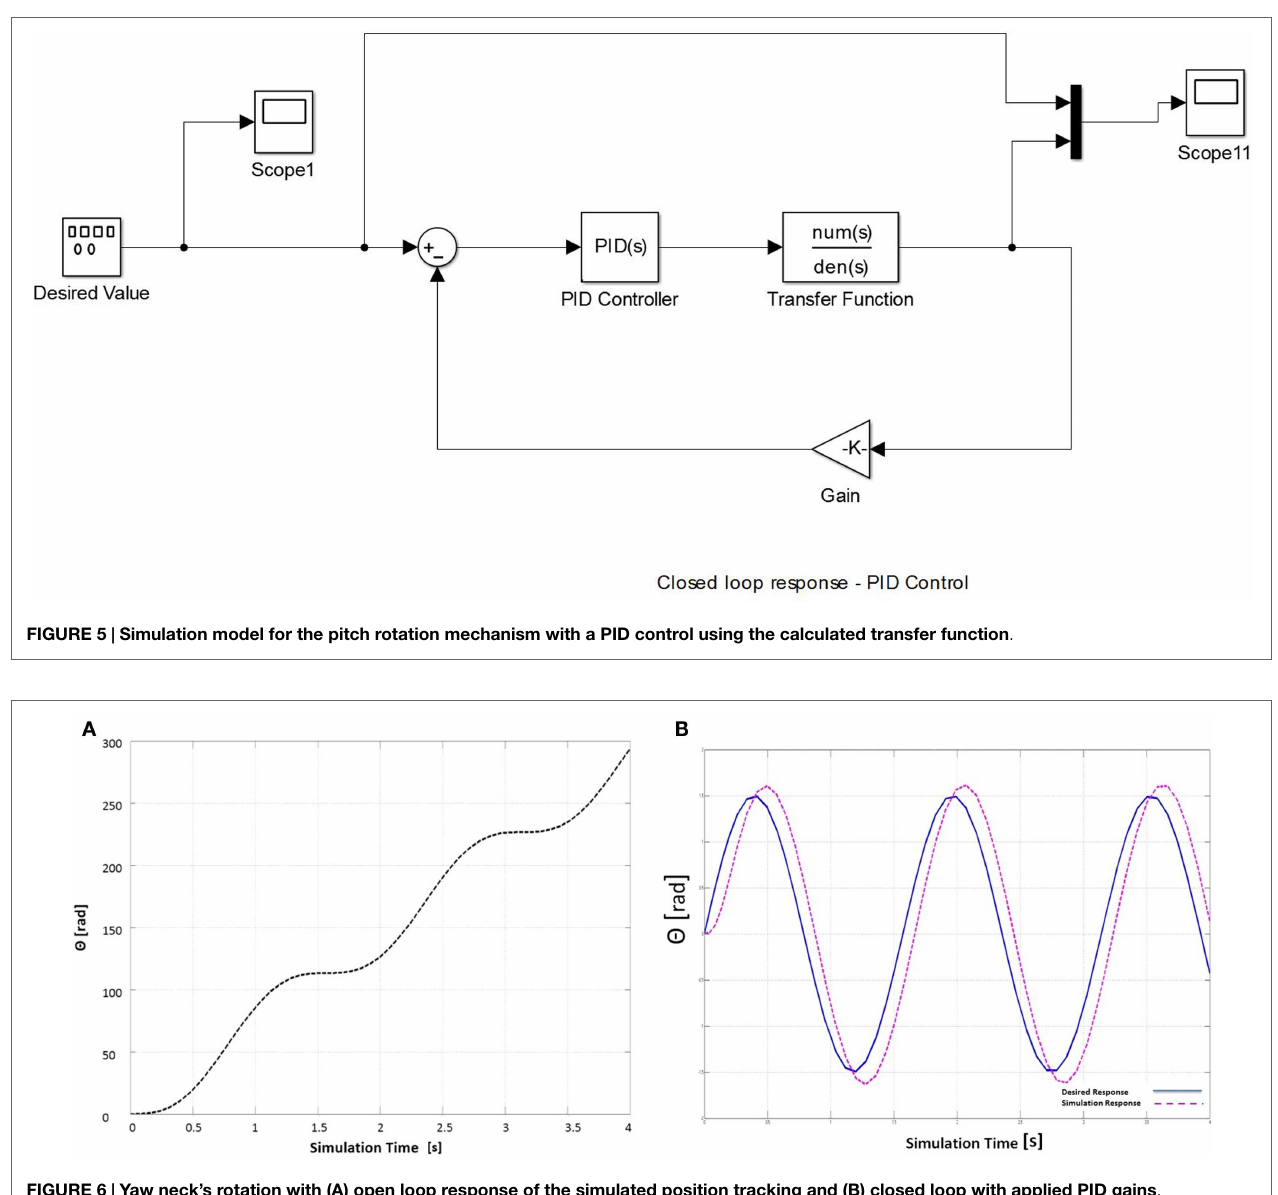
FIGURE 6 | Yaw neck’s rotation with (A) open loop response of the simulated position tracking and (B) closed loop with applied PID gains